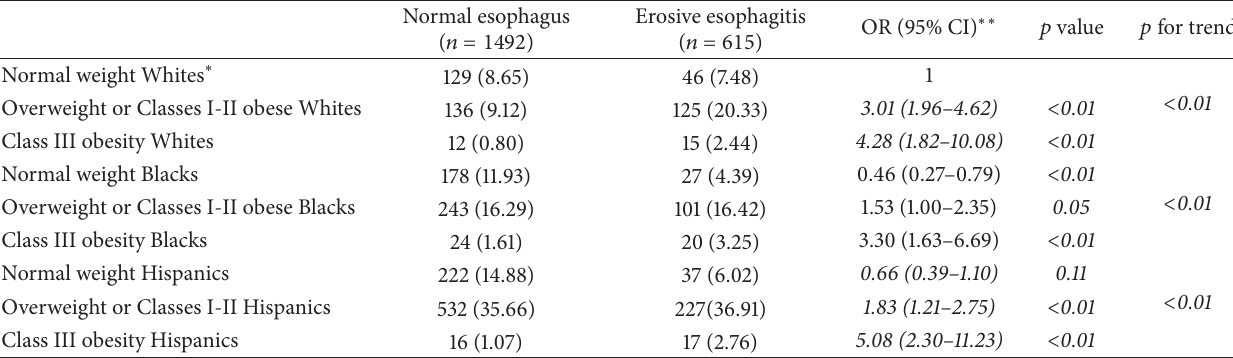
Table 4: Joint effects of obesity and ethnicity/race ∗ on erosive esophagitis. Normal esophagus ( 𝑛 = 1492